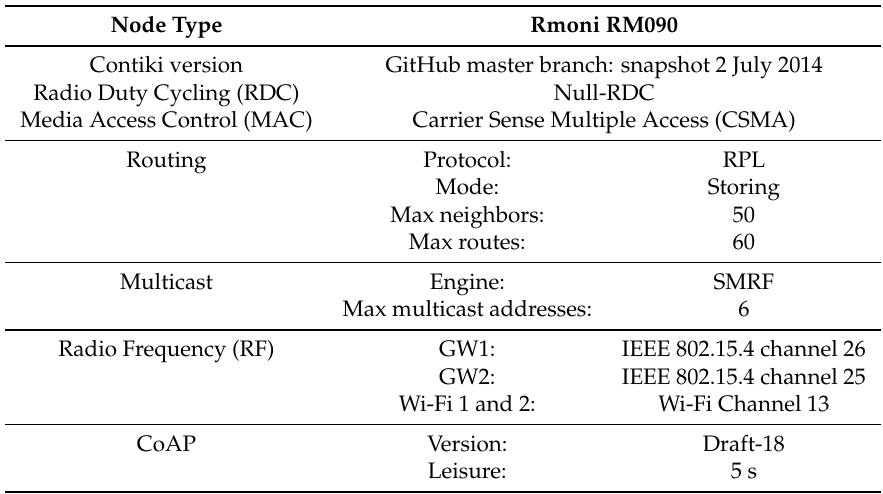
Table 6. Evaluation experiments